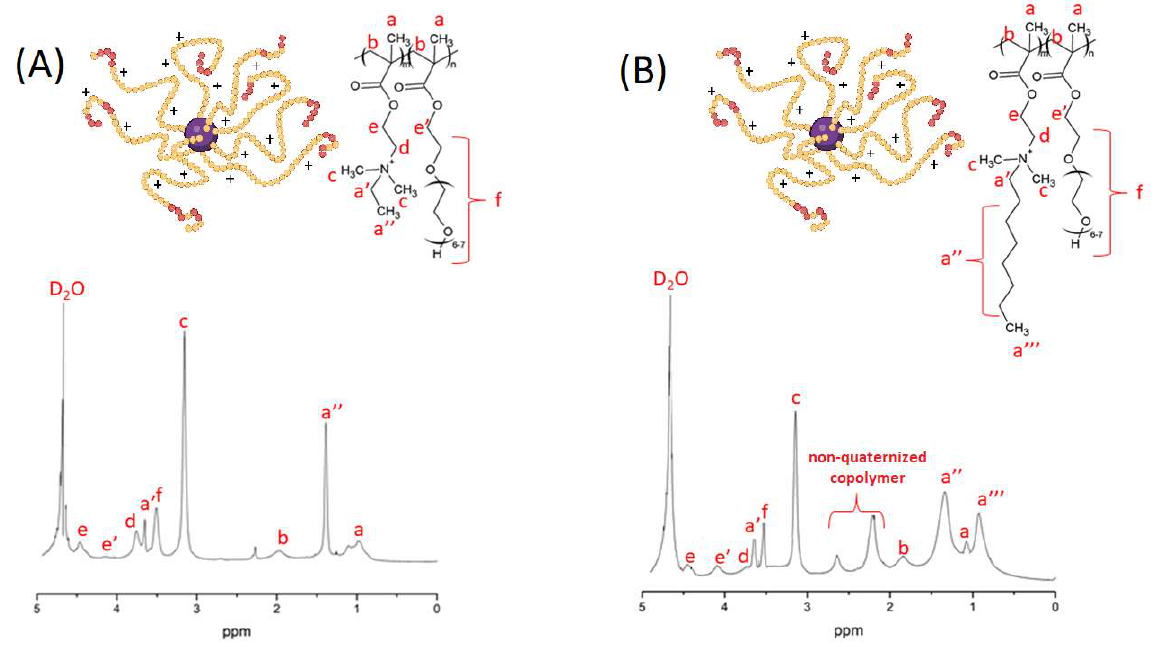
Figure 2. 1 H NMR spectrum of the star copolymer SC after quaternization reaction with: ( A ) bromo-